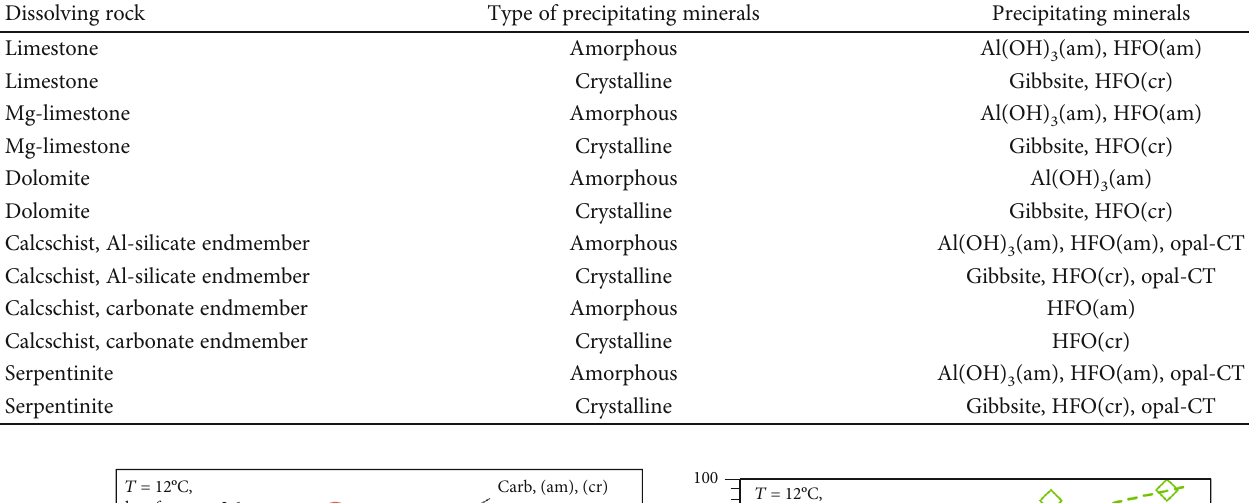
Table 3: Precipitating solid phases during the simulations of the progressive dissolution of the limestone, the Mg-limestone, the dolomite, and the serpentinite, as well as the carbonate and Al-silicate endmembers of the calcschist considered in this work.